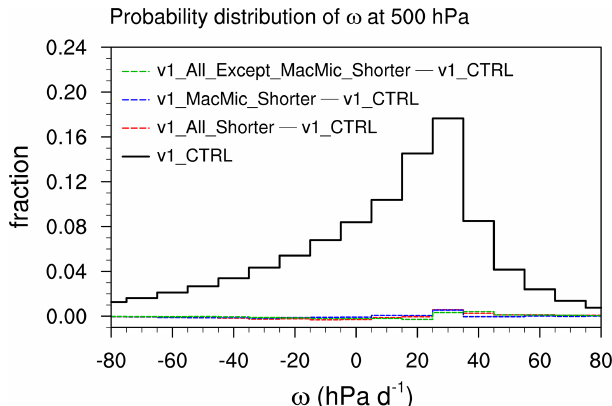
Figure 11. Frequency of occurrence of circulation regimes defined by monthly mean 500hPa vertical velocity (ω) in the latitude band 35 ◦ S–35 ◦ N. The solid black line shows the probability distribution in v1_CTRL. Dashed colored lines show differences in the proba- bility distribution between other simulations and